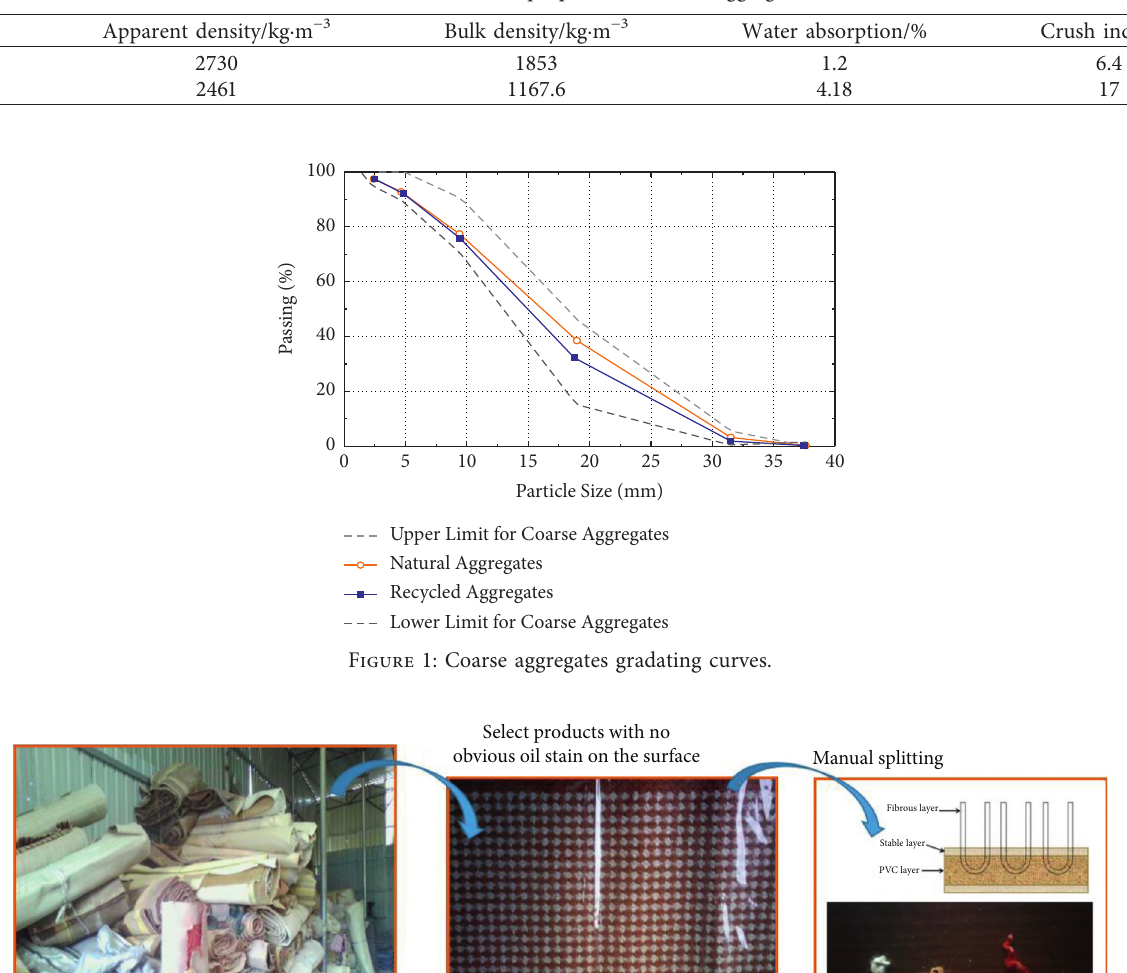
Table 2: Basic material properties of coarse aggregates.